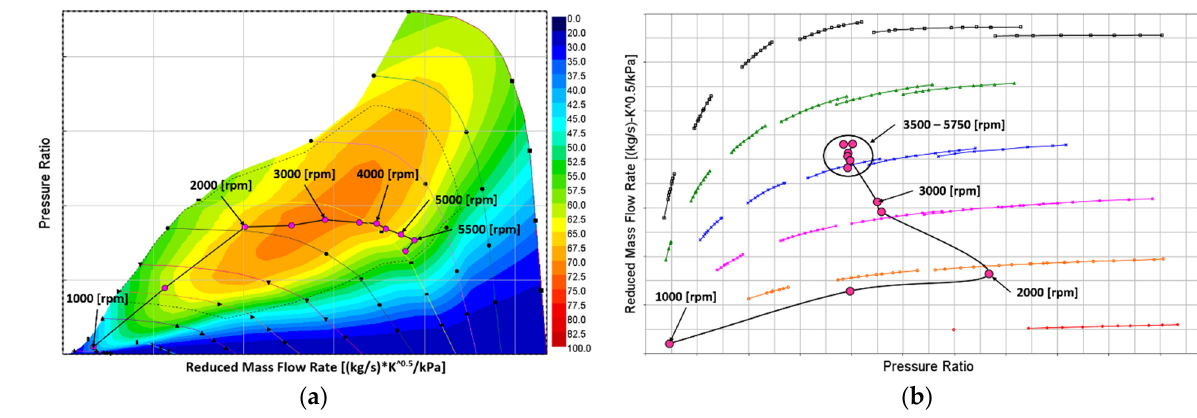
Figure 18. Operating points on ( a ) compressor and ( b ) turbine maps.